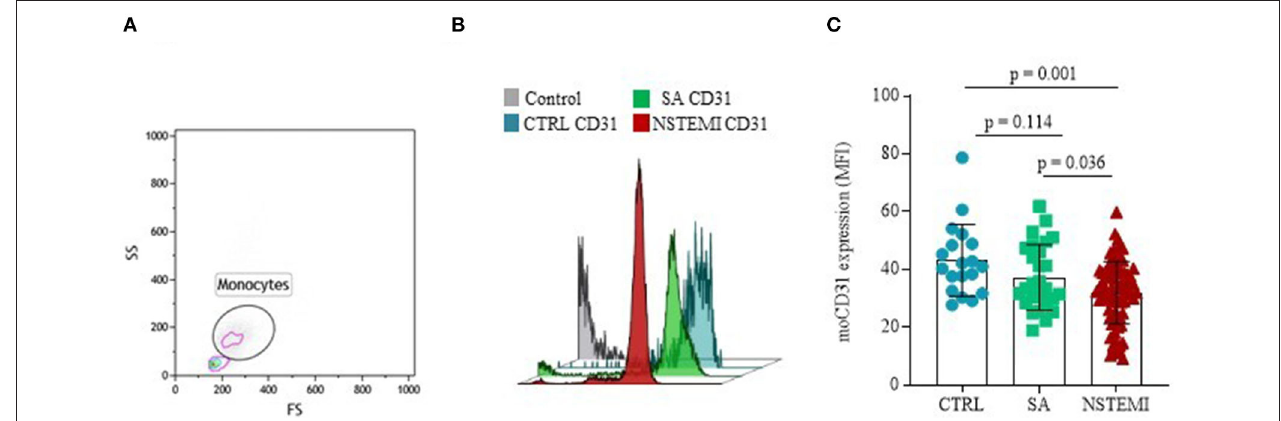
FIGURE 2 | CD31 expression on monocytes. Graphs showing the surface protein expression of CD31 on CD14 + monocytes assessed by flow-cytometry (mean ± SD) in basal conditions. (A) Representative flow cytometry forward vs. side scatter plot of monocyte subset; (B) Representative flow cytometry overlay plot; (C) Data analysis of mo CD31 surface protein expression between the three groups (CTRL, Control individuals; FS, Forward Scatter; MFI, Median Fluorescence Intensity; mo CD31, monocyte CD31; NSTEMI, Non-ST-Elevation Myocardial Infarction; SA, Patients with Stable Angina; SD, Standard Deviation; and SS, Side Scatter).